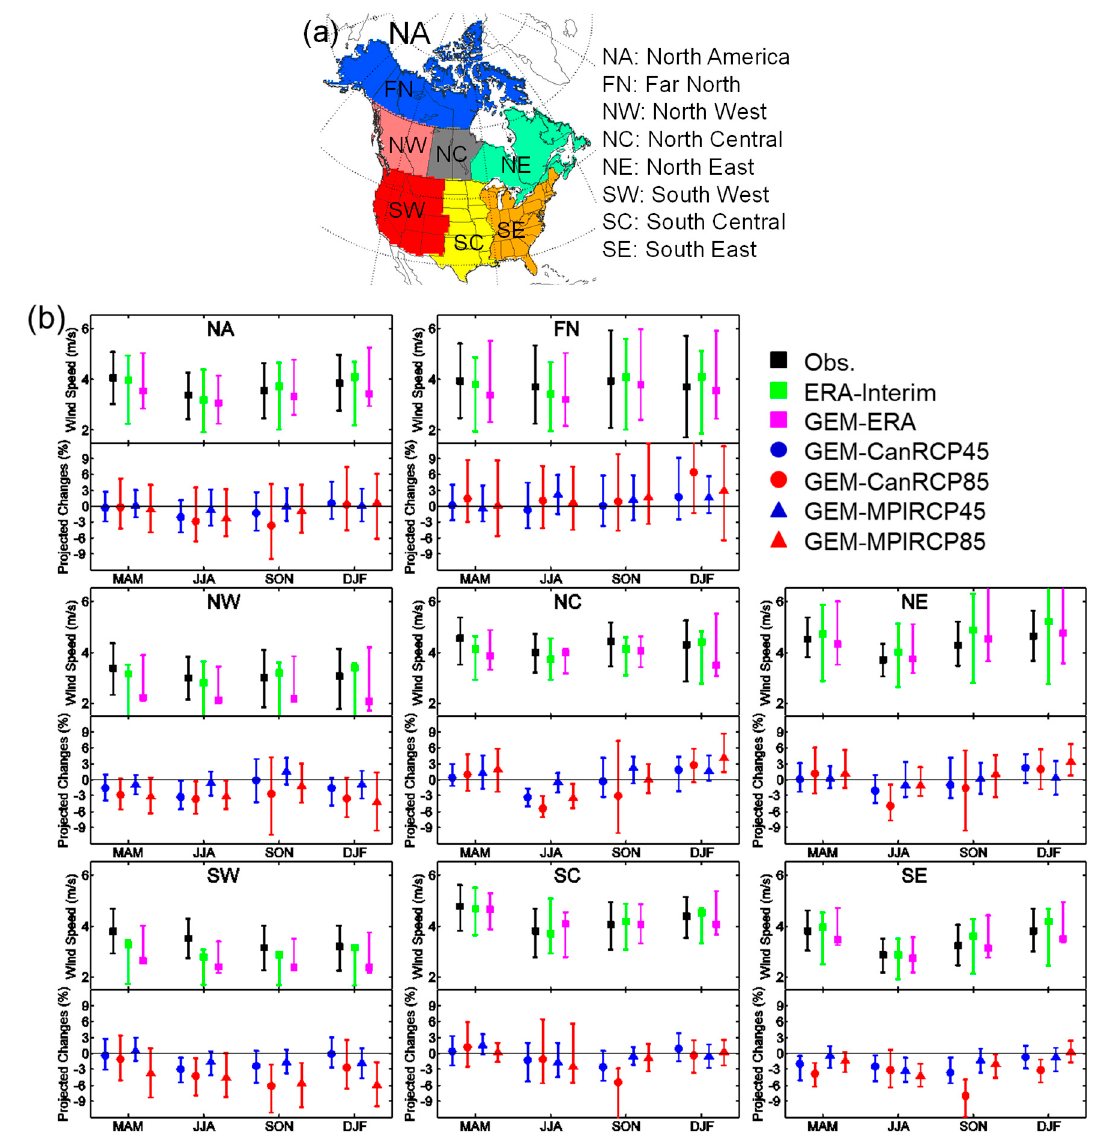
Figure 5. Seasonal mean wind speeds for observations, ERA-Interim, and GEM-ERA for North America (NA) and seven sub-regions of NA, shown in ( a ), for the 1981–2010 period (upper panels in sub-plots in ( b )). For ERA-Interim and GEM-ERA, grid points nearest to the observation stations are considered for calculation. Projected changes (in %) to seasonal mean wind speeds for the four GEM model simulations for the future 2071–2100 period, with respect to the current 1981–2010 period, are presented in the lower panel of each sub-plot in ( b ) based on all grid points of each region. Symbol and error-bar represent median and 1-sigma (15.9%–84.1%) range, respectively.